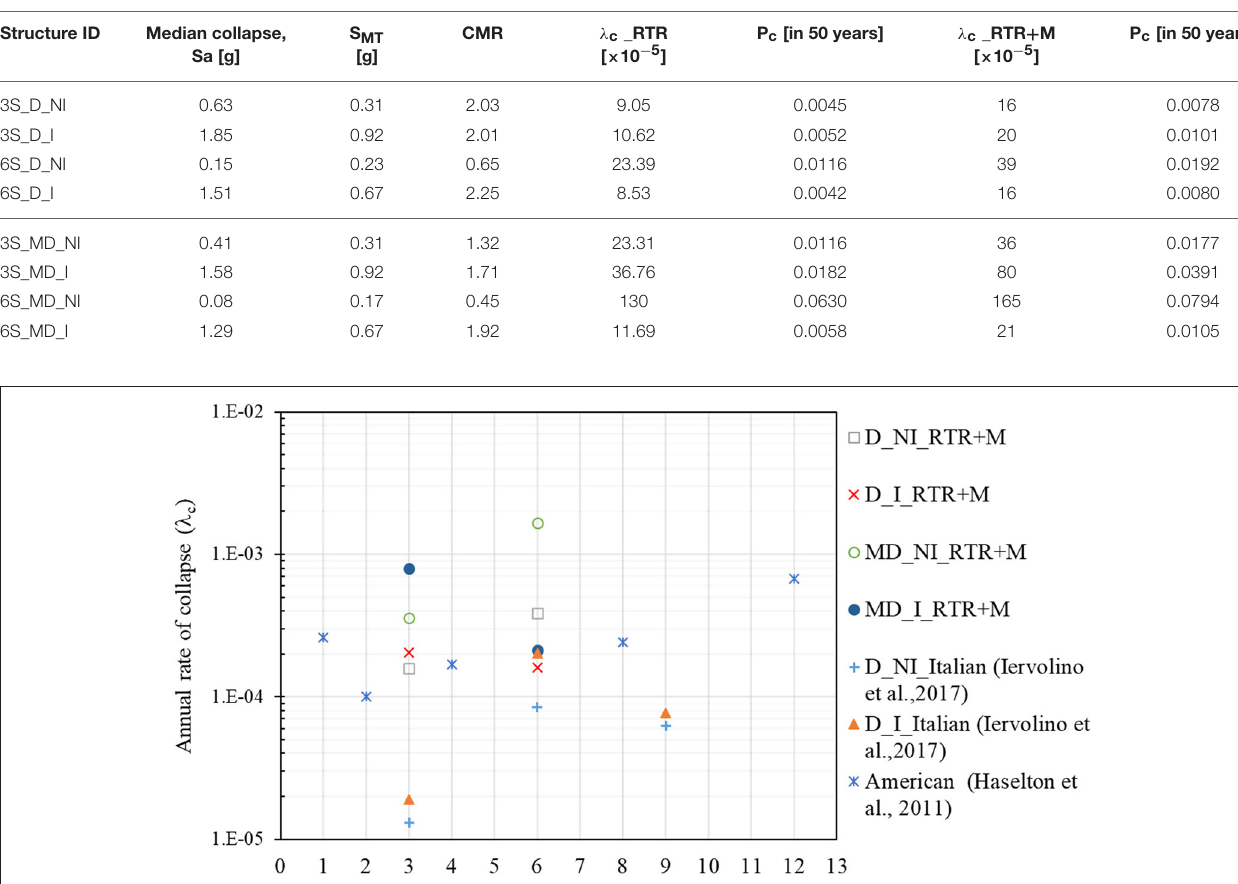
TABLE 3 | Result of seismic collapse assessment for ductile and moderately ductile RC MRF with and without URM infill walls. Structure ID